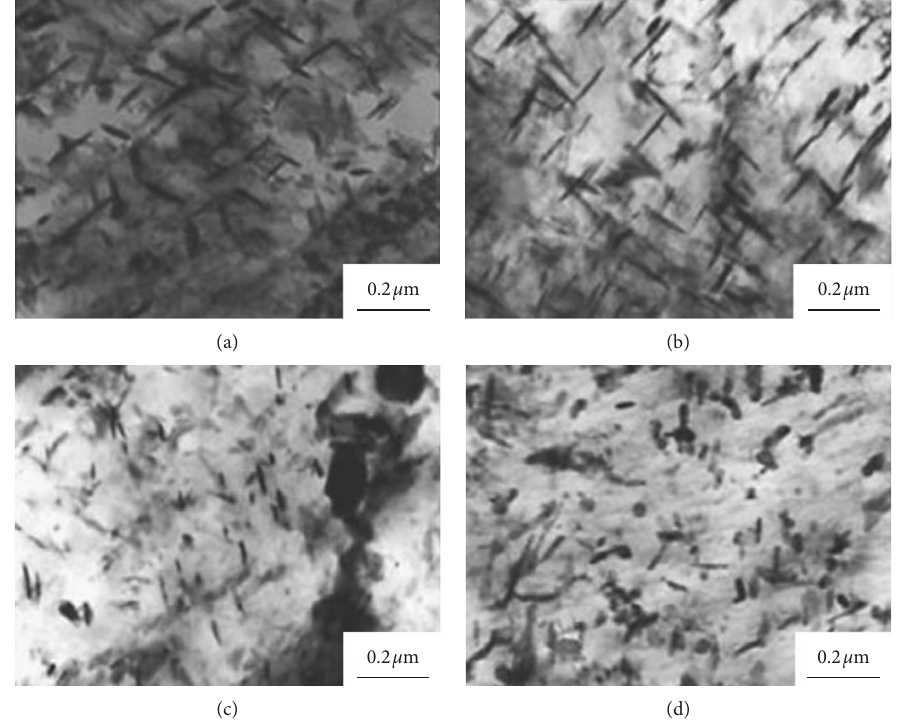
Figure 11: Fracture morphologies of 34CrNiMo6-xCe specimens quenched in oil (870 ° C/30min) and tempered at 650 ° C: (a) x quenched in oil; (b) x 0.025, quenched and tempered; (c) x (cid:31)